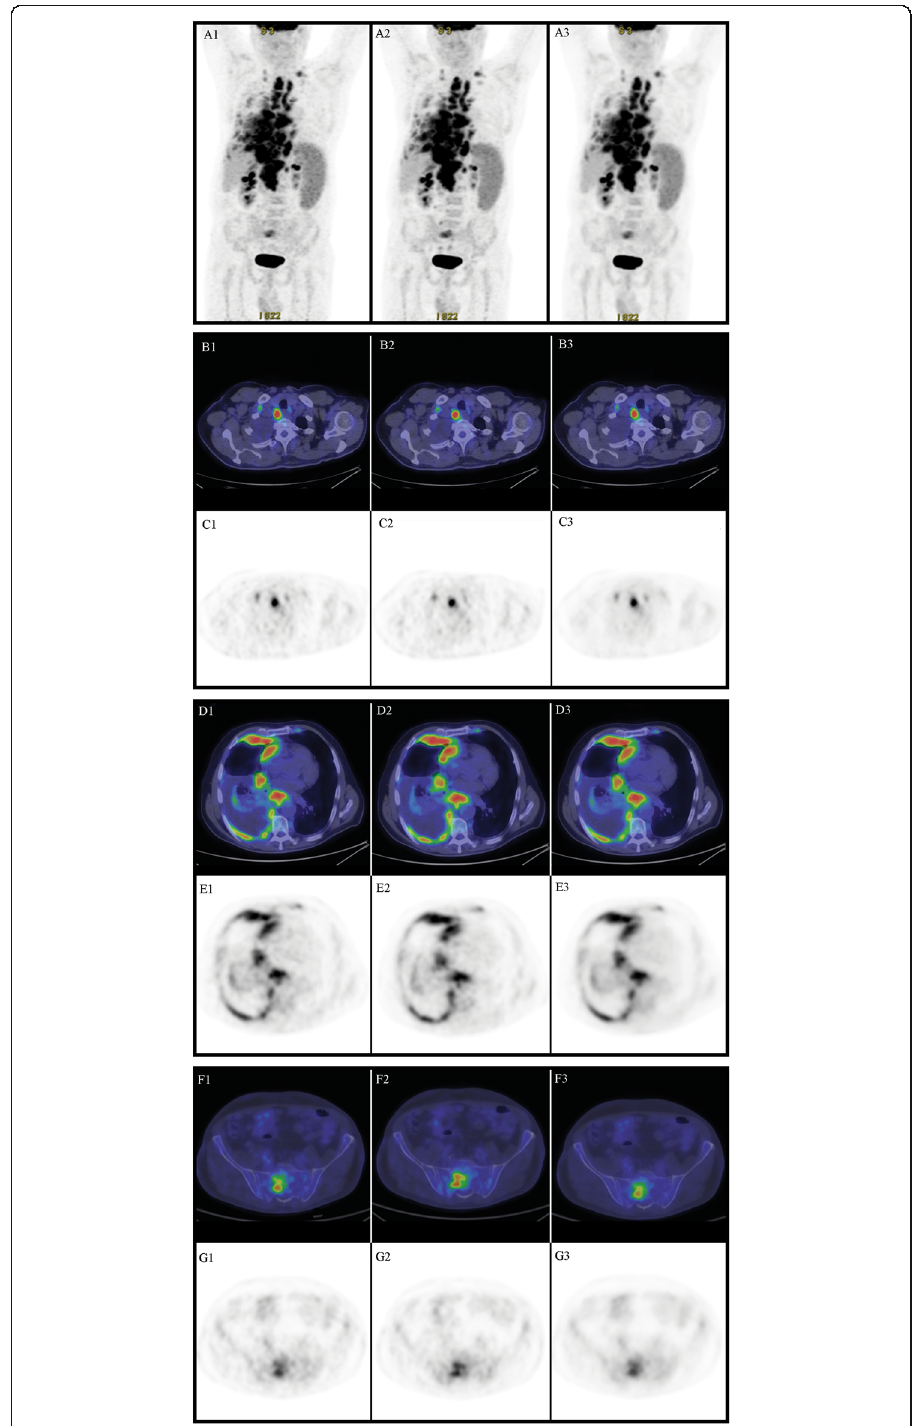
Fig. 6 (See legend on next